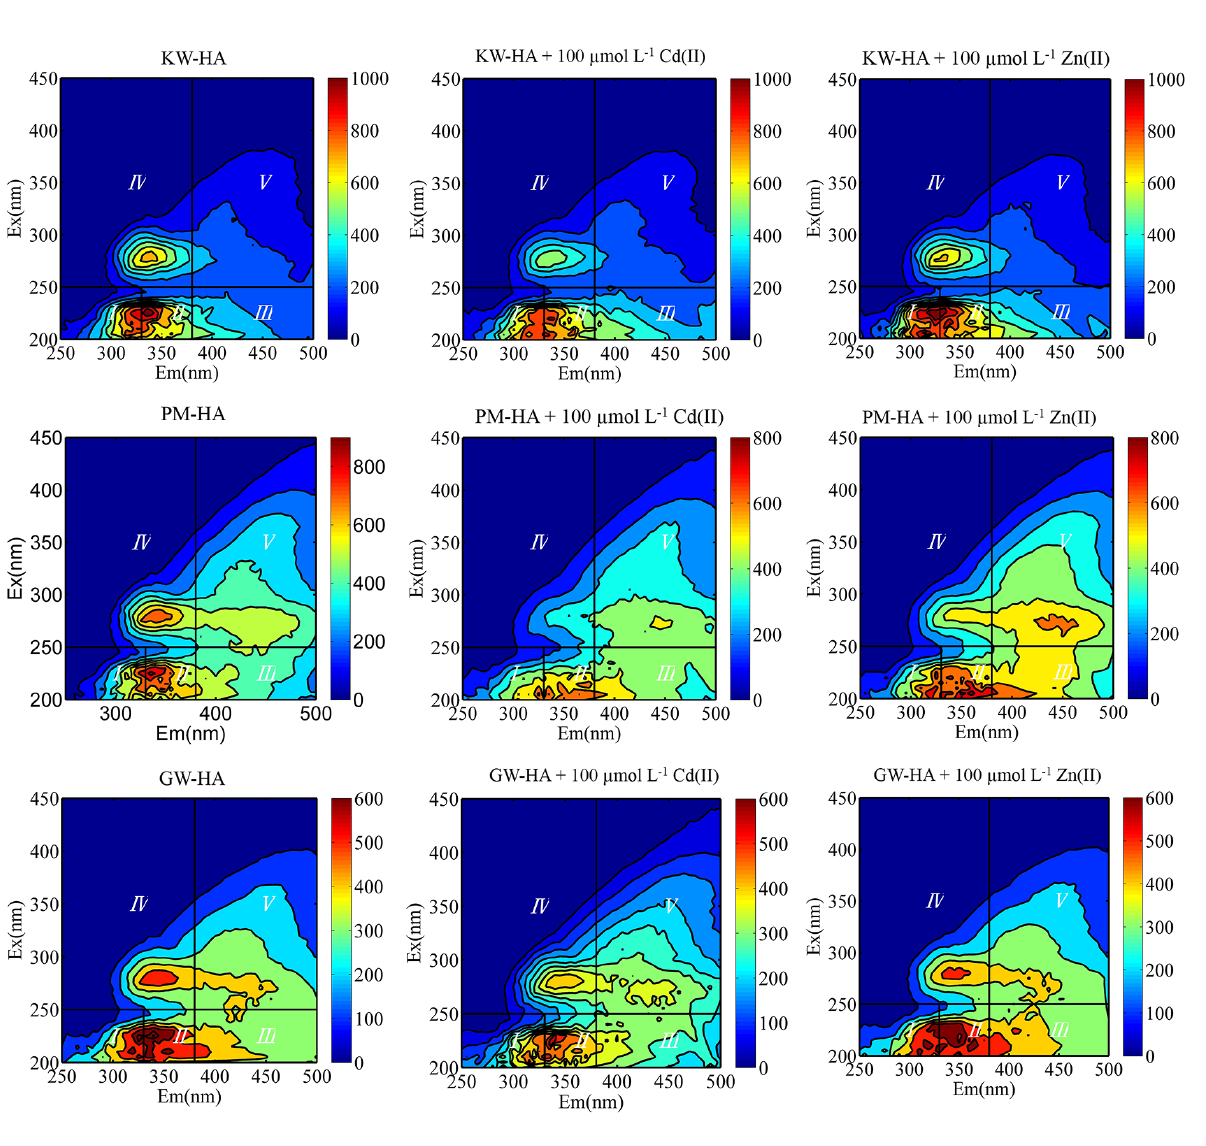
Figure 4: EEM spectra of the three HAs with or without titration of Cd(II) and Zn(II) at a total concentration of 100